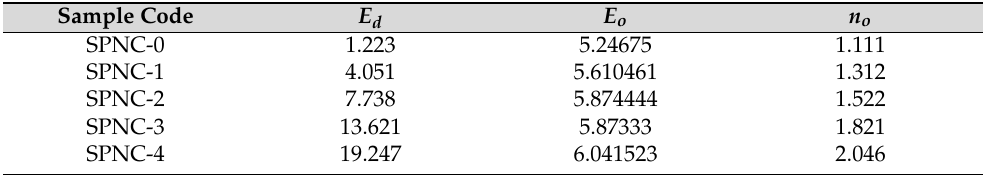
Table 6. Various parameters calculated based on W–D single oscillator